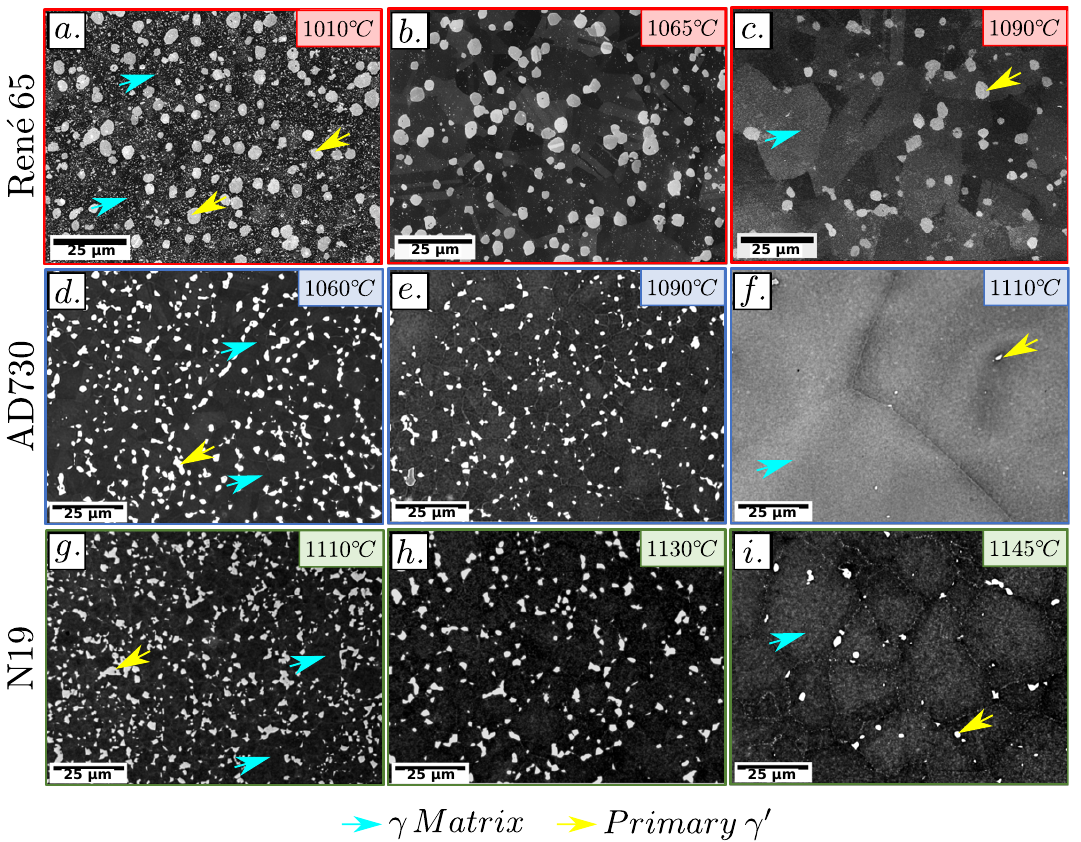
Figure 3. SEM SE micrographs obtained using the first preparation protocol after 4 h heat treatment for René 65 at ( a ) 1010 ◦ C; ( b ) 1065 ◦ C; ( c ) 1090 ◦ C; for AD 730 at ( d ) 1060 ◦ C; ( e ) 1090 ◦ C; ( f ) 1110 ◦ C and optical images obtained using the second preparation protocol for N 19 at ( g ) 1110 ◦ C; ( h ) 1130 ◦ C and ( i ) 1145 ◦ C ( N 19). Bright particles are the primary γ ’-phase precipitates undissolved during